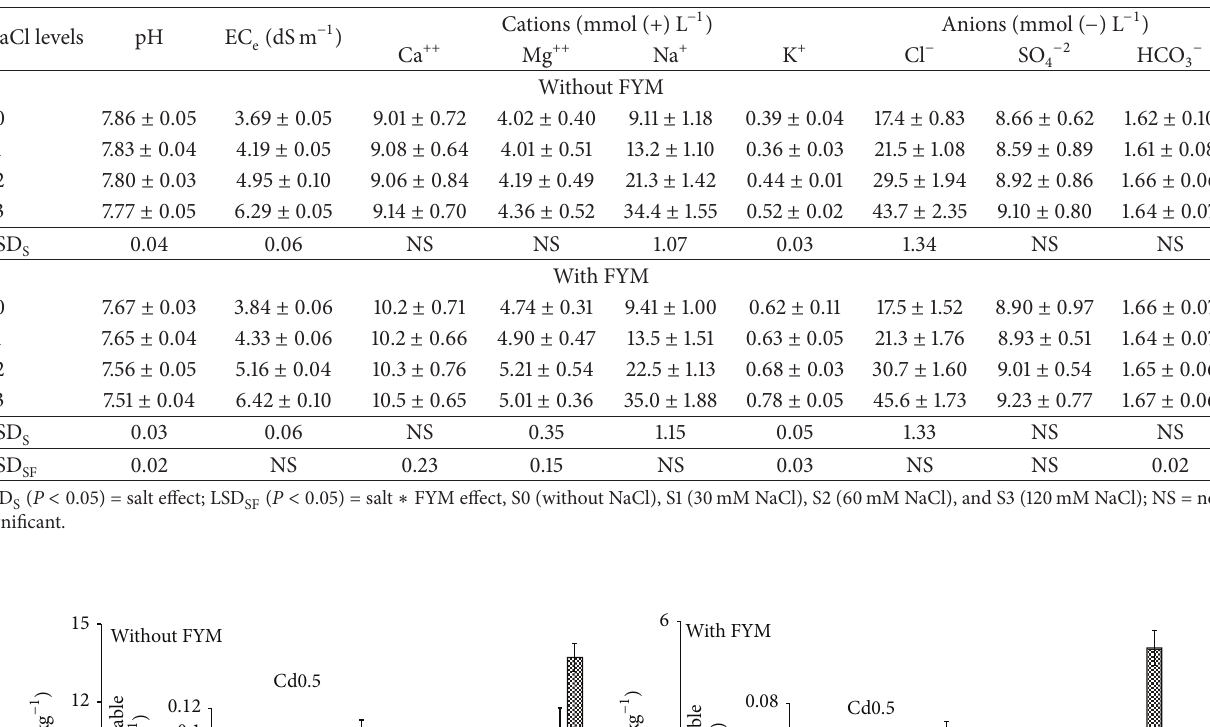
, and soluble cations and anions ( ± SD). e